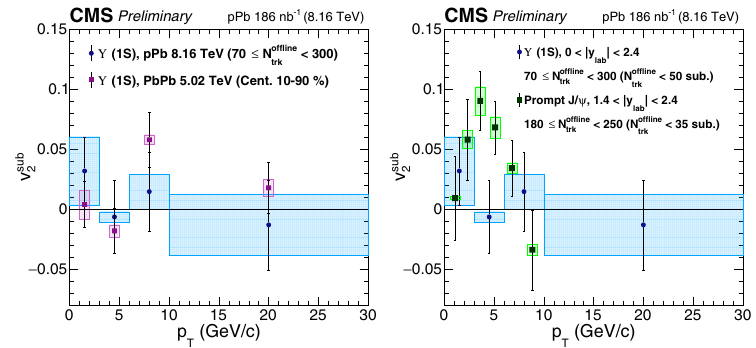
values for Υ (1S) mesons [16] are compared to the corresponding 2 values for prompt J /ψ mesons within 1 . 4 < 2 < 250, where a low-multiplicity range of N o ffl ine N o ffl ine trk ≤